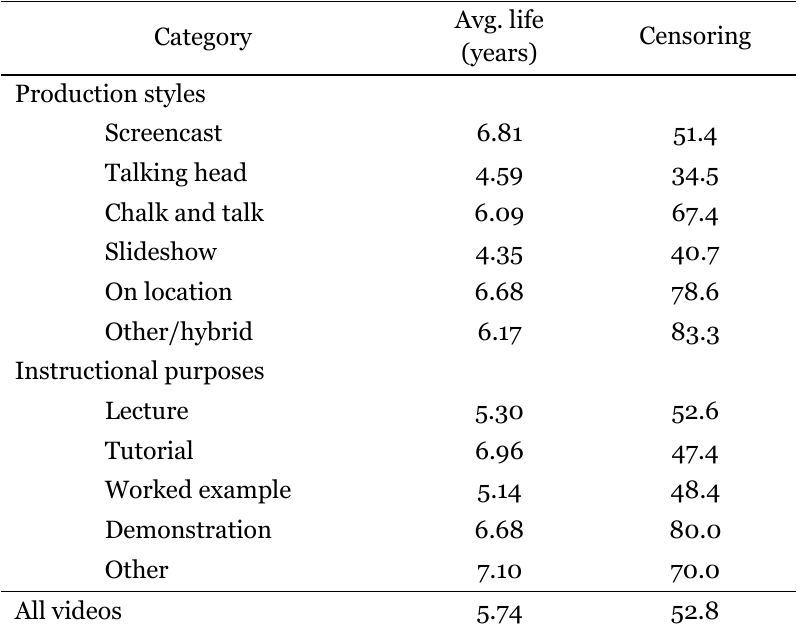
Table 3 Average Life Span and Censoring of Surveyed